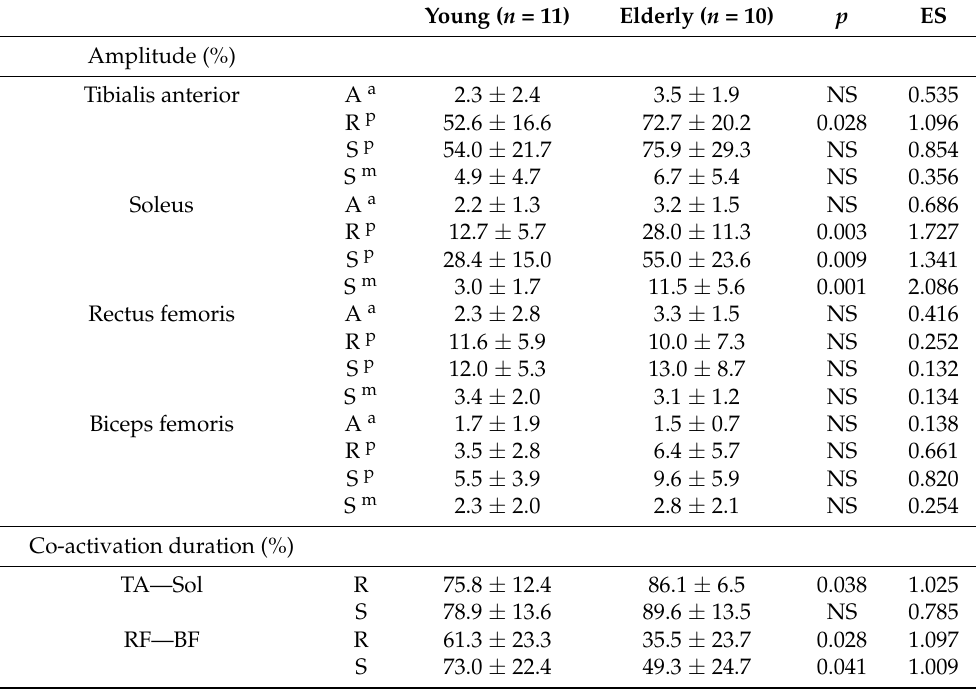
Table 3. Electromyography amplitude and co-activation duration during emergency